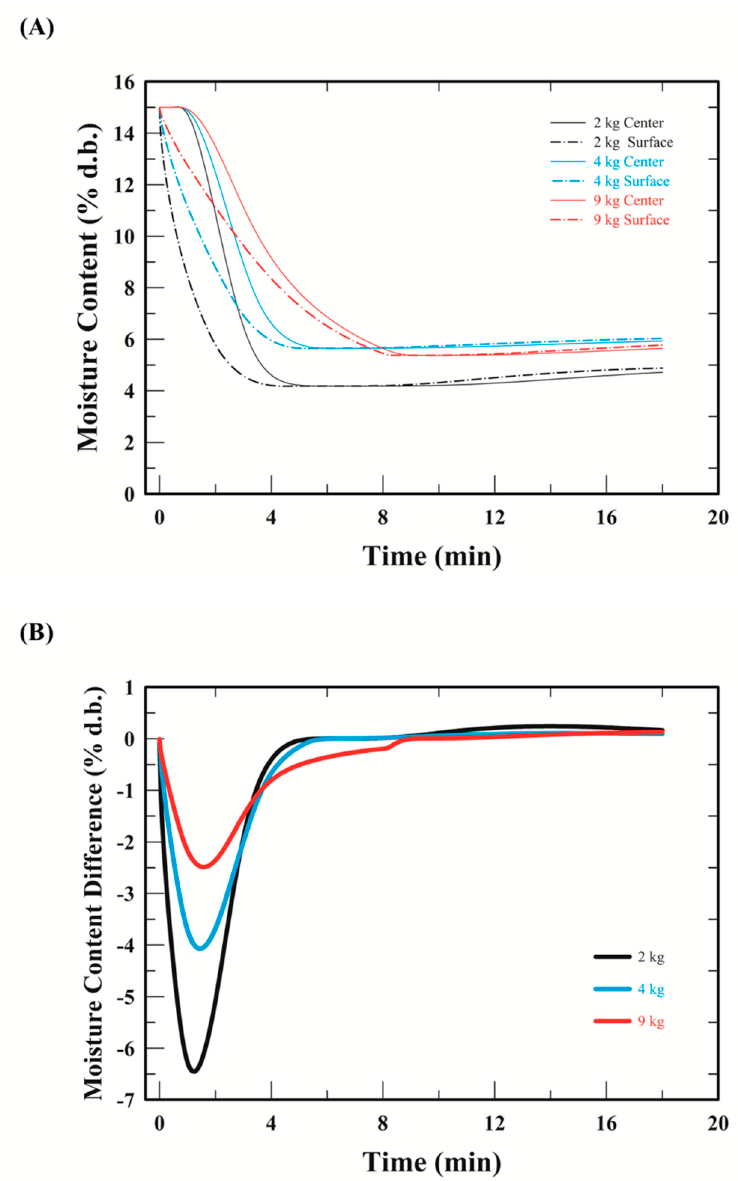
Figure 4. Simulated profiles of the moisture content ( A ) and the moisture content difference ( B ) of wheat germ during drying with different WG loadings. Solid lines represent the wheat germ center; dash-dot lines represent the wheat germ surface.